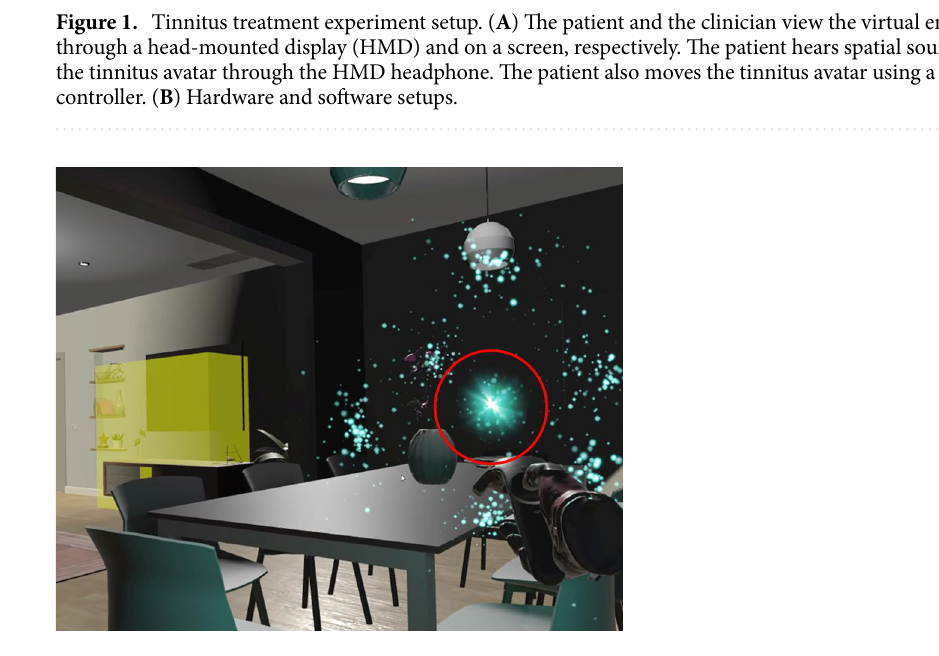
Figure 2. Example of virtual environment for the treatment session. The sparkling object emitting particles (red circle) is a tinnitus avatar. The yellow area is the tinnitus disposal site in which the patients are instructed to discard the tinnitus